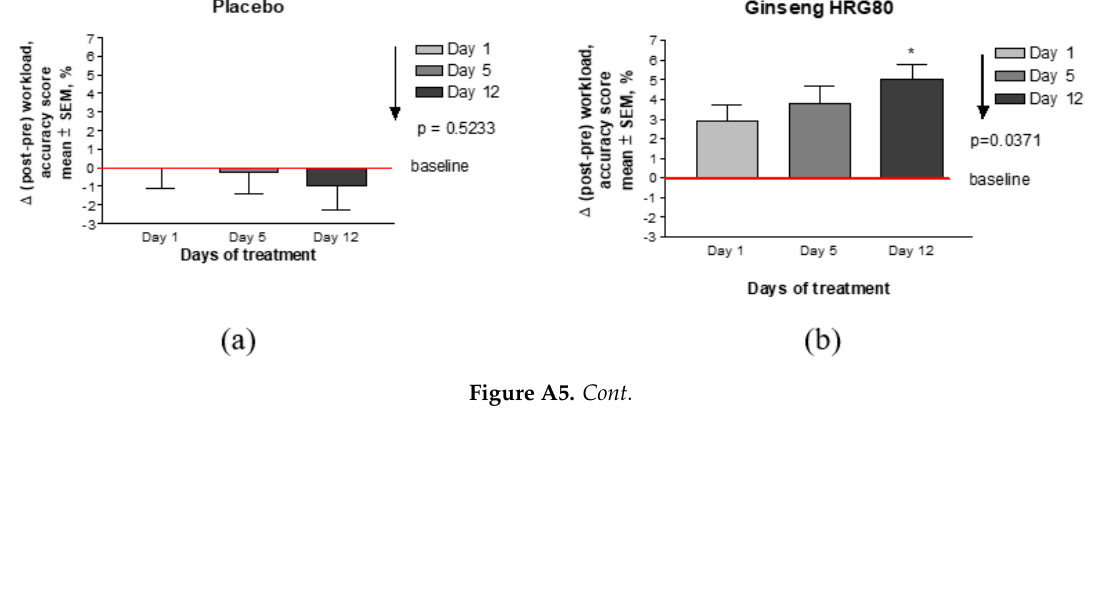
Figure A4. Difference between post- and preworkload attention scores (error %, mean ± SEM, Y -axis) in d2 test at Days 0, 1, 5, and 12 in ( a ) placebo, ( b ) ginseng HRG80, and ( c ) ginseng control treatment groups. Change significance shown by symbols * p < 0.05, ** p < 0.01, *** p < 0.001; ns, not significant. Within-group improvement of cognitive function on stress background at end of treatment (Day 12 vs. Day 0) was observed only during the treatment with ginseng HRG80 ( p = 0.0047).